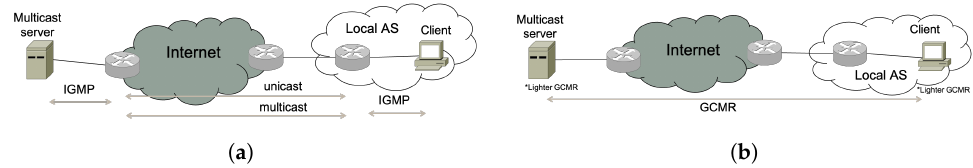
Figure 5. Protocols required for multicast: ( a ) conventional scheme: a unicast routing, a multicast routing, and a membership subscription protocol; ( b ) GCMR only requires